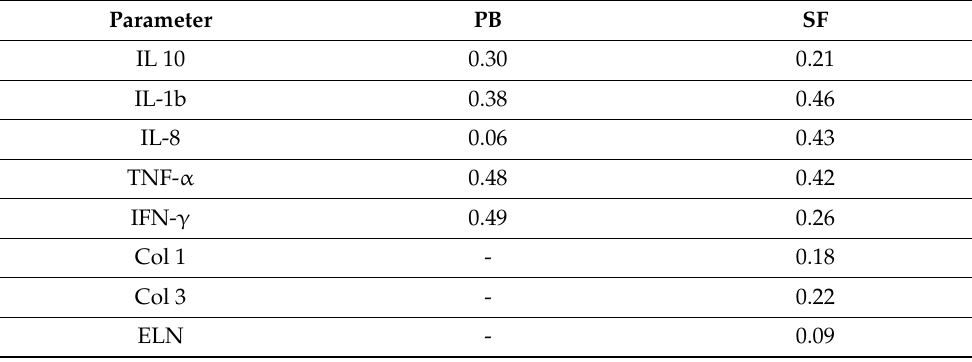
Table 4. Comparison of mRNA expressions of cytokines, collagens, and elastin between partially and completely ruptured ligaments. Numbers indicate the p value. No significant difference was